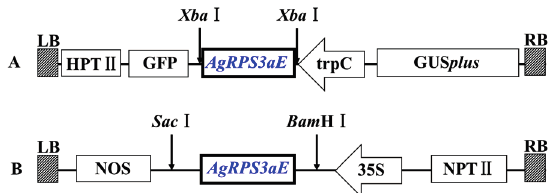
Figure 4. Construction of vectors containing AgRPS3aE for transformation. ( A ) T-DNA map of the binary vector pGFPGUS plus -trpC:: AgRPS3aE used to transform M. oryzae ; ( B ) T-DNA map of the binary vector pBI121:: AgRPS3aE used for the Arabidopsis and tobacco transformations. GFP: green fluorescent protein gene; HPTII: hygromycin resistance gene; GUS plus : β -glucuronidase gene; trpC: A. nidulans TrpC promoter; 35S: CaMV 35S promoter; NOS: NOS terminator; NPTII: kanamycin resistance gene.